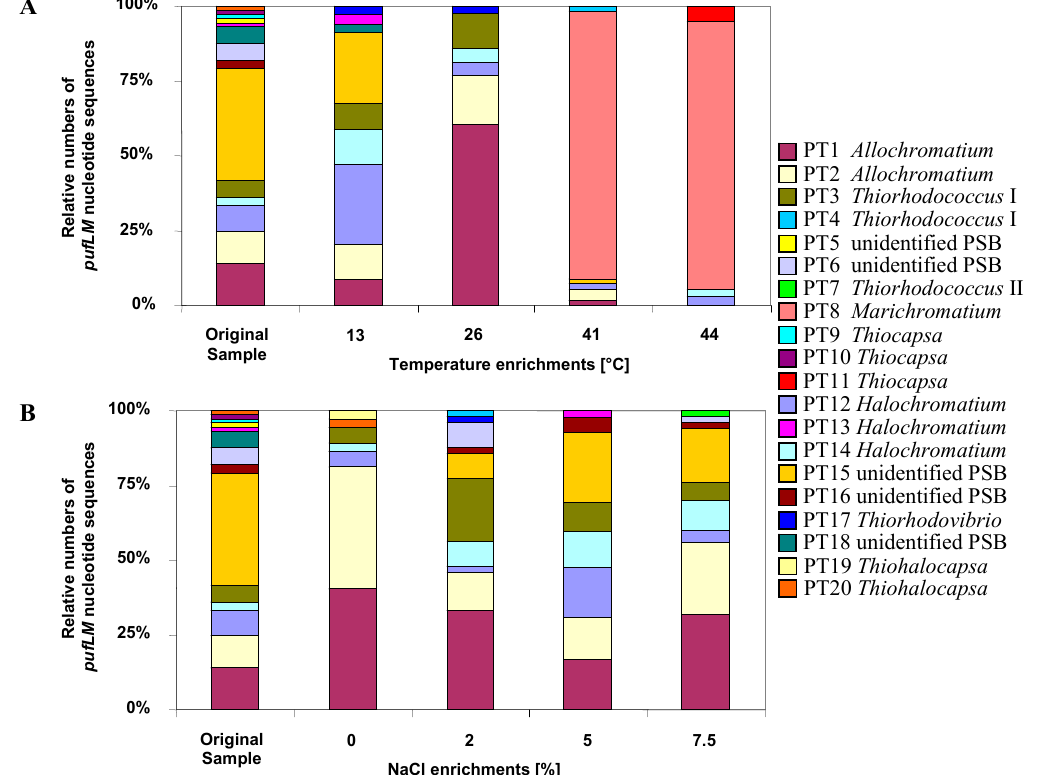
Figure 3. The contribution of different phylotypes to the community of purple sulfur bacteria (PSB) in a Baltic Sea lagoon is shown. Twenty phylotypes were identified in original sample and under different enrichment conditions on the basis of pufLM gene sequences. The figure depicts the composition in the sample and under the influence of different temperatures and salt concentrations (from [9]).